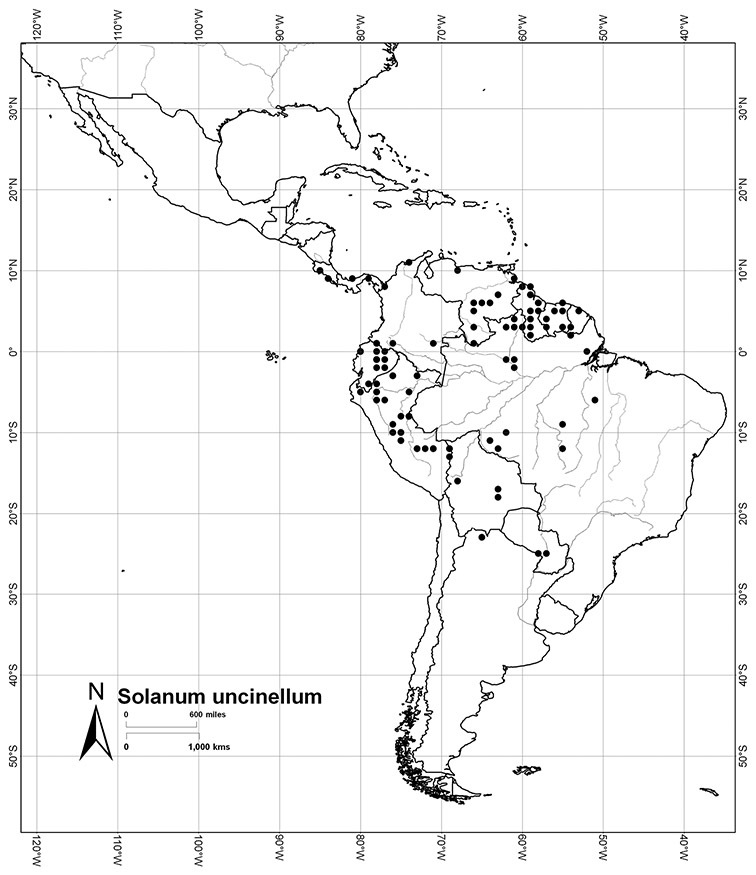
Distribution of Solanum uncinellum Lindl.